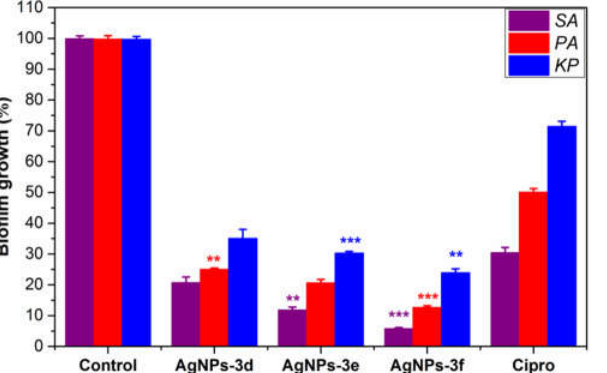
Figure 7. Inhibition of bacterial biofilm formation by the most potent antibiotics (AgNPs-3d, AgNPs-3e, and AgNPs-3f) as compared to a positive control (Cipro) and negative control (DI water). (** p < 0.005, *** p <